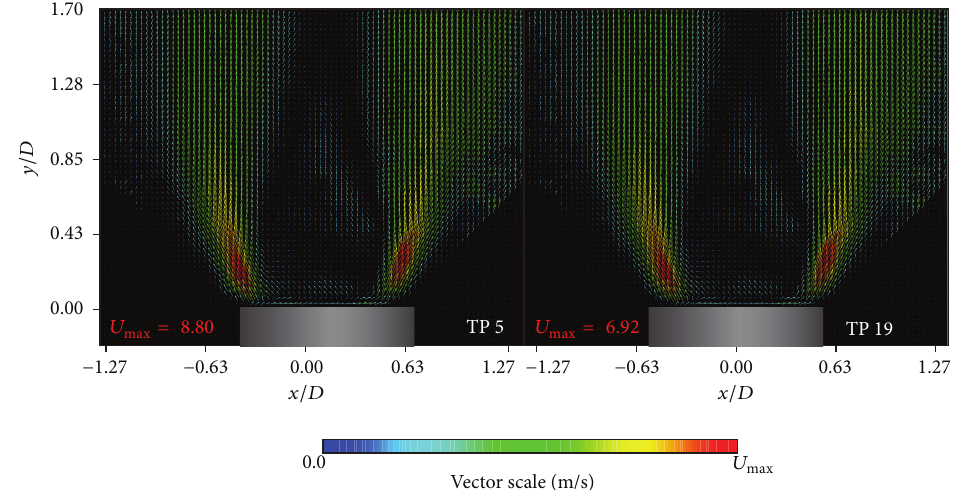
Figure 6: Vector plots of TP 5 and TP 19 in the AGSB with altered premix air flow rate and pilot CO 2 flow rate as detailed in Table 1: vectors indicate velocity and direction.